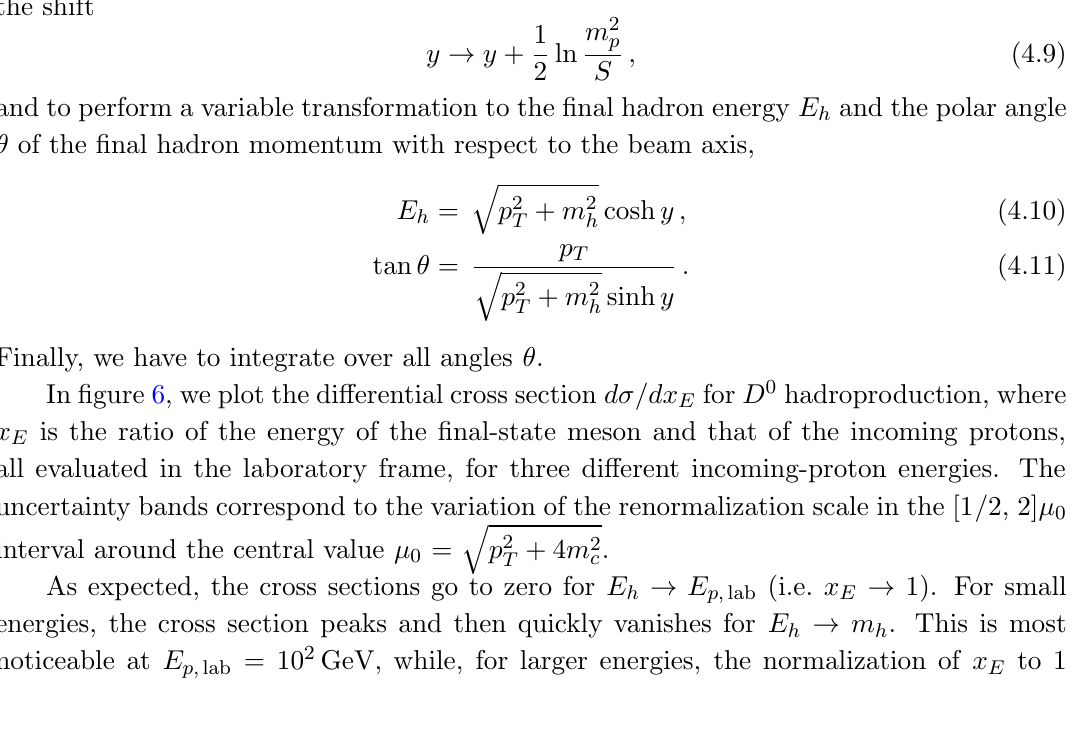
Figure 6 . Di(cid:11)erential cross sections d (cid:27) /d x initial-state protons with laboratory energies E p; lab = 10 2 GeV, E p; lab = 10 5 GeV and E p; lab = 10 9 GeV. Central values correspond to the choice of scales (cid:22) r = with (cid:24) = 0 : 5, the charm mass (cid:12)xed to m c = 1 : 3 GeV, and the central set of the CT14nlo PDF (cid:12)t. The uncertainty bands correspond to the (cid:22) r scale variation explained in the